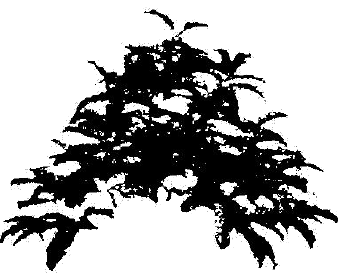
Figure 6.The extraced point cloud data of a vegetation canopy.